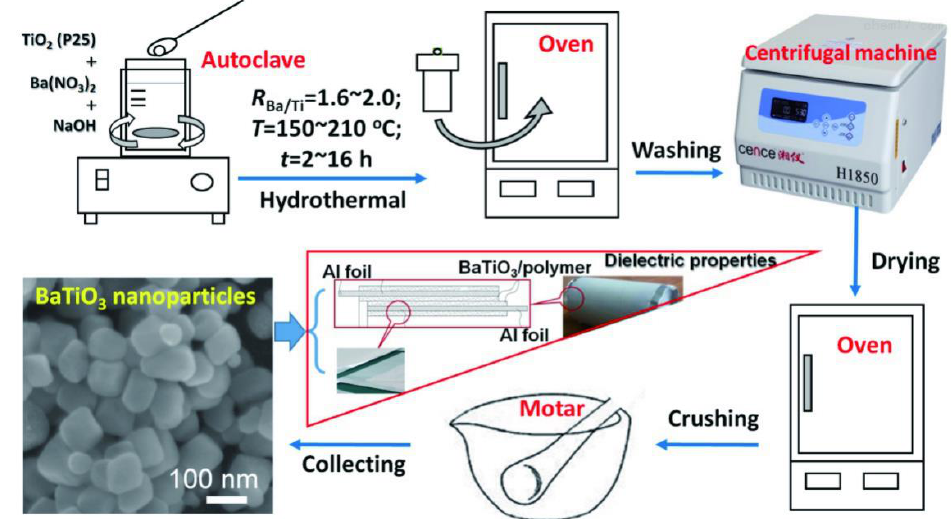
Figure 1. Schematic of the hydrothermal synthesis of BaTiO 3 nanocrystals using TiO 2 (P25) nanoparticles as the seeds and Ti source. Table 1. A summary of experimental conditions for hydrothermal synthesis of BaTiO 3 nanoparticles.